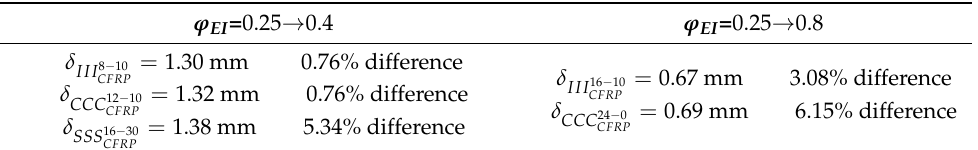
Table 6. FEA results—maximum deflections under bending loading for the proposed multi-cell beams (using square